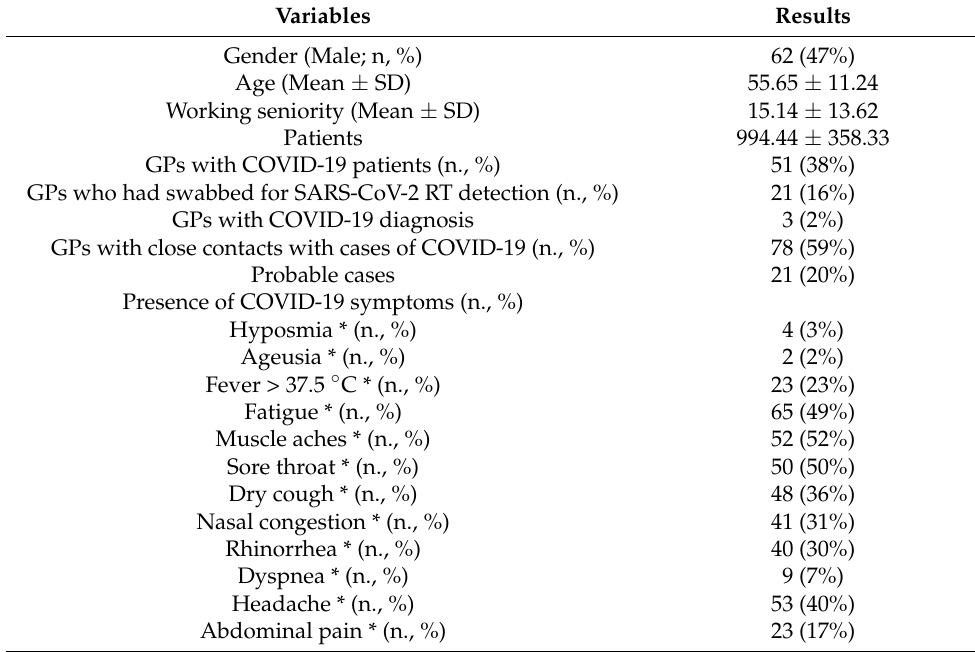
Table 1. Characteristics of participating general practitioners (GPs).